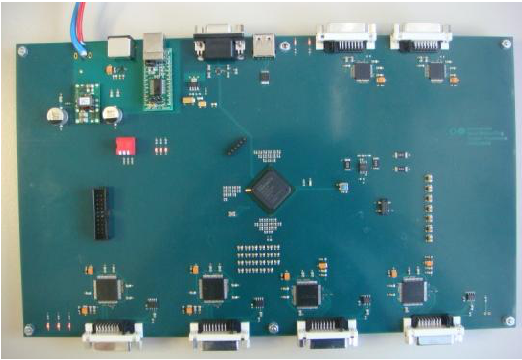
Figure 1. FPGA based combiner